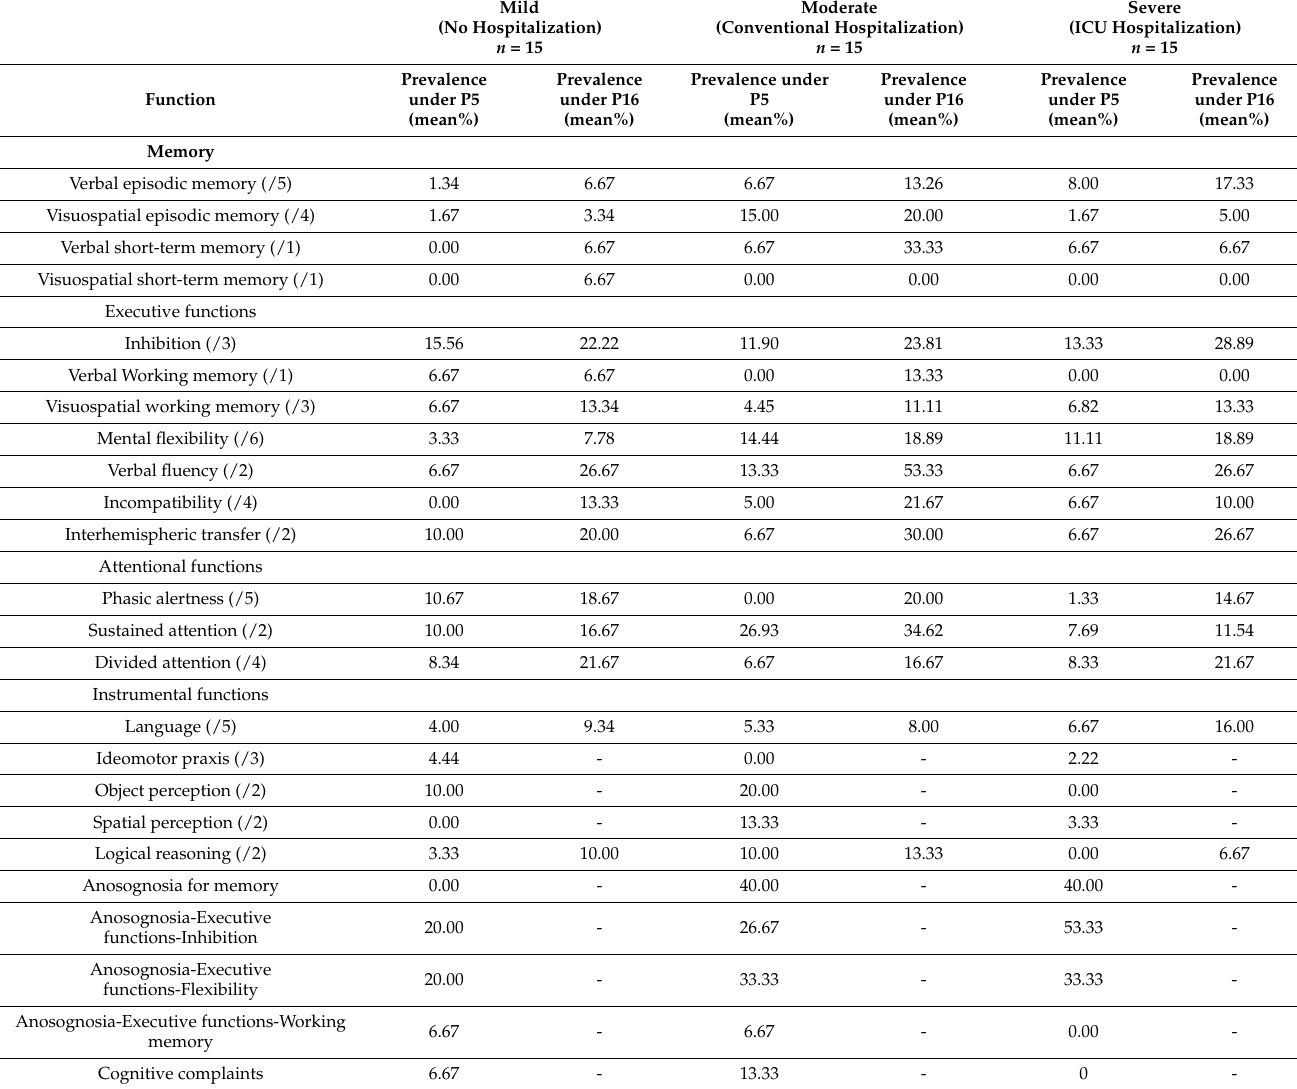
Table 2. Cumulated prevalence deficits for each cognitive function among patients with mild, moderate, or severe COVID-19 6–9 months